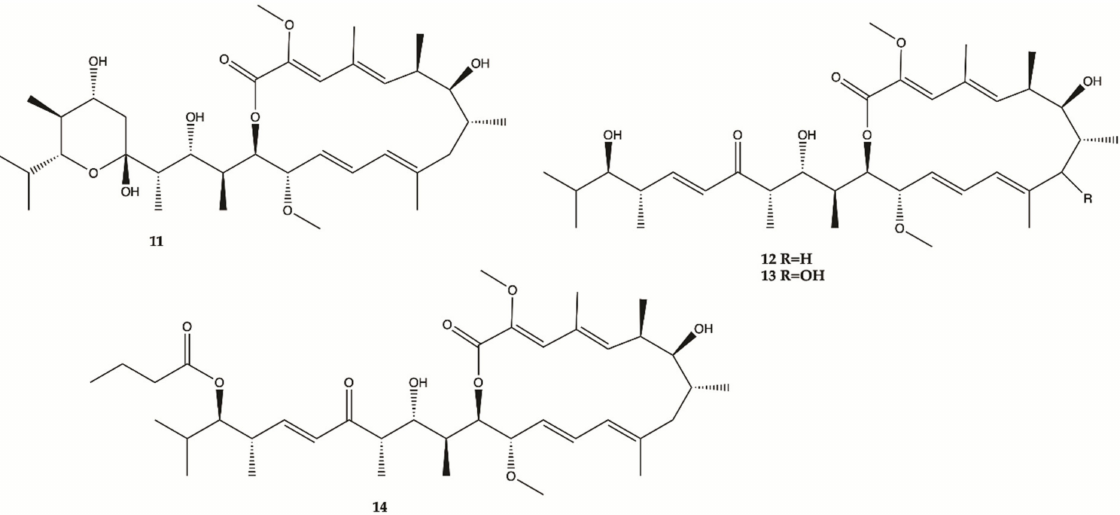
Figure 6. Bafilomycins 11 – 14 isolated from marine green algae Ulva pertusa